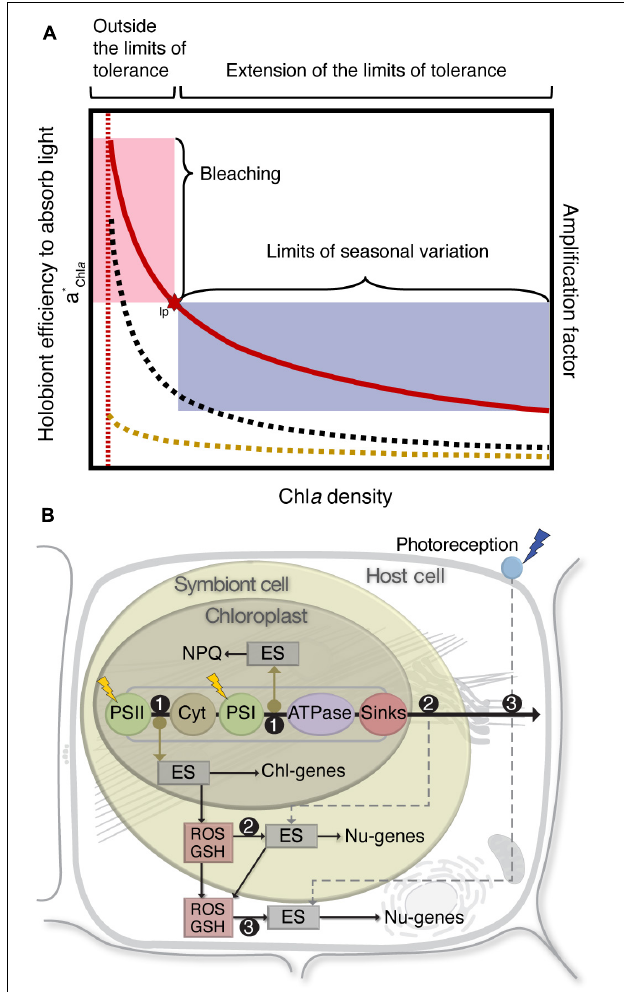
FIGURE 1 | Seasonal phenotypic variation and cellular communication in symbiotic corals. (A) Seasonal changes in holobiont light absorption efficiency (quantified by means of the specific absorption coefficient of Chlorophyll a , a* Chl a ) as a function of pigment (Chl a ) density in corals. Lines show the comparative increase in light absorption efficiency of freshly isolated symbiont cells (yellow dashed line), absorption by intact coral laminae (black dashed line), and the estimated enhanced factor of light absorption resulting from the comparison of both optical measurements (red line). This amplification or “enhancement factor” is the consequence of the capacity of the coral skeleton to induce multiple scattering of light. Inflection point ( Ip ) of a* Chl a sets a limit for the variation of the coral photoacclimatory response (shaded blue area) and the development of the bleached phenotype (shaded red area) [modified from Enríquez et al. (2005)]. (B) Responses in the different cellular compartments of the holosymbiont: (1) Chloroplasts perceive the environmental change as “light stress,” the increase in electron transfer produces over-reduction in the PQ-pool and a (cid:49) pH + (with associated NPQ) across the thylakoid membrane; the net result is the decrease in Fv/Fm and the generation of an alternative homeostatic state. (2) Symbiont cells perceive the change as “oxidative stress,” energy sensors (ES) activate changes in gene expression; the net result is the decrease in symbiont pigmentation and an alternative homeostatic state. (3) Host cells perceive the change as “thermal stress,” energy sensors activate changes in gene expression, and immune responses facilitate symbiont trafficking to adjust symbiont cell density in the host tissue; the net result is an alternative homeostatic state that sets the limits of acclimation. (Chl-genes) Chloroplast genes, (Nu-genes) Nuclear genes, (GSH)